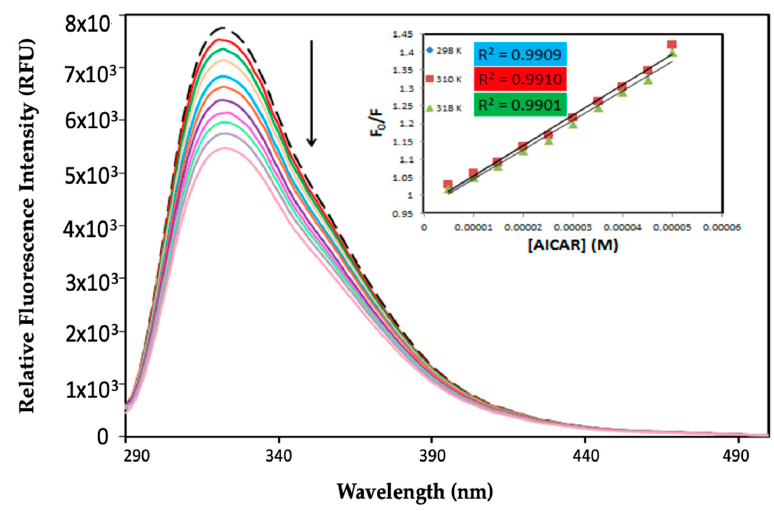
Figure 1. Fluorescence quenching spectra of 5-aminoimidazole-4-carboxamide ribonucleoside–human serum albumin (AICAR–HSA) complexes. Fixed [HSA] = 5 µ M, increasing concentration of [AICAR] = 5–50 µ M, pH = 7.4, T = 298 K, in 10x-PBS buffer.